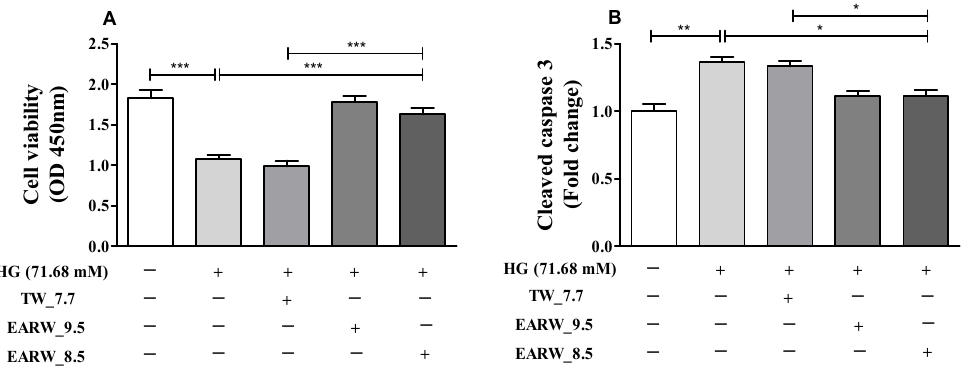
Figure 1. Effect of EARW_8.5 on cell viability and cleaved caspase-3 in HG-induced HK-2 cells. ( A ) Cell viability of HK-2 cells was analyzed after induction with 71.68 mM glucose and treatment with 10% TW_7.7, EARW_9.5, or EARW_8.5 for 24 h. ( B ) Cleaved caspase-3 was analyzed by an enzyme-linked immunosorbent assay (ELISA). Values were calculated as mean ± standard error of mean (SEM). * p < 0.05, ** p < 0.01, and *** p < 0.001 indicate significant differences when tested with one-way analysis of variance